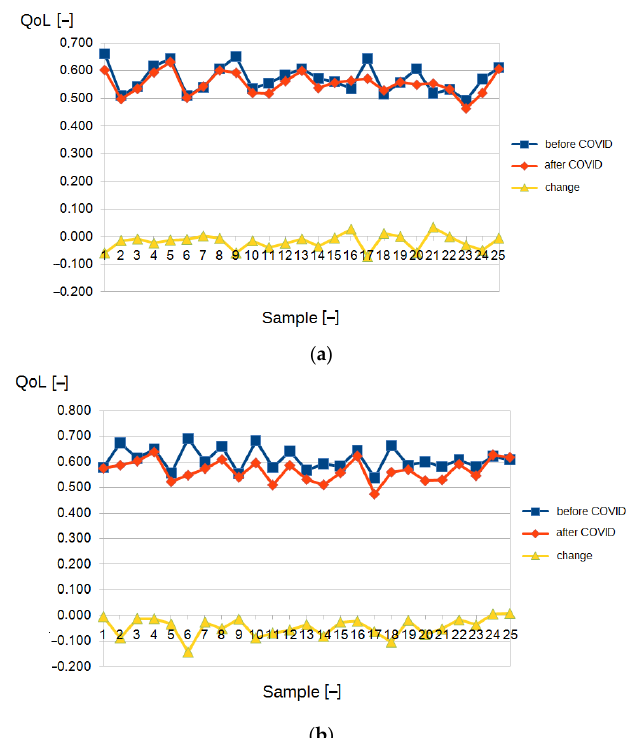
Figure 2. Results of fuzzy Quality of Life assessment: Model 1, ( a ) group 1, ( b ) group 2. Model 2 is a hierarchical system similar to Model 1, but with an additional initial layer in the form of simple fuzzy systems for the results from each type of questionnaire, which performs an initial normalization of the questionnaire data to the 0–1 interval (Table 8, Figures 3 and 4). Table 8. Fuzzy models: Model 2,groups 1 and 2.